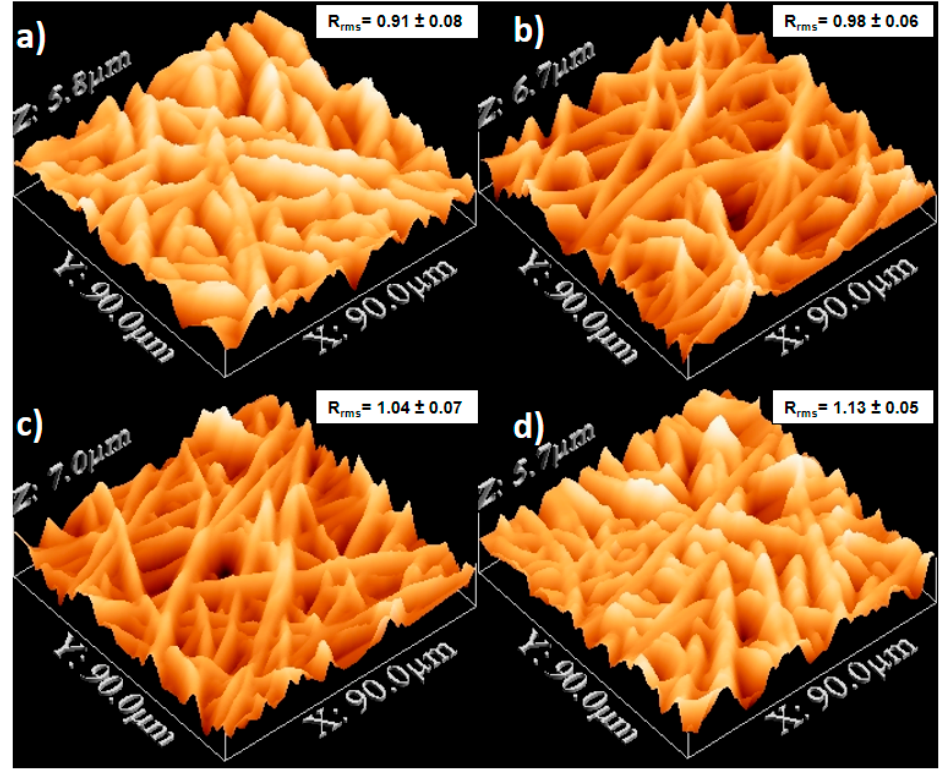
Figure 4. Atomic force microscopy (AFM) images of the electrospun PCL scaffolds prepared with voltages of: ( a ) 10 kV, ( b ) 15 kV, ( c ) 20 kV, and ( d ) 25 kV. voltages of: ( a ) 10 kV, ( b ) 15 kV, ( c ) 20 kV, and ( d ) 25